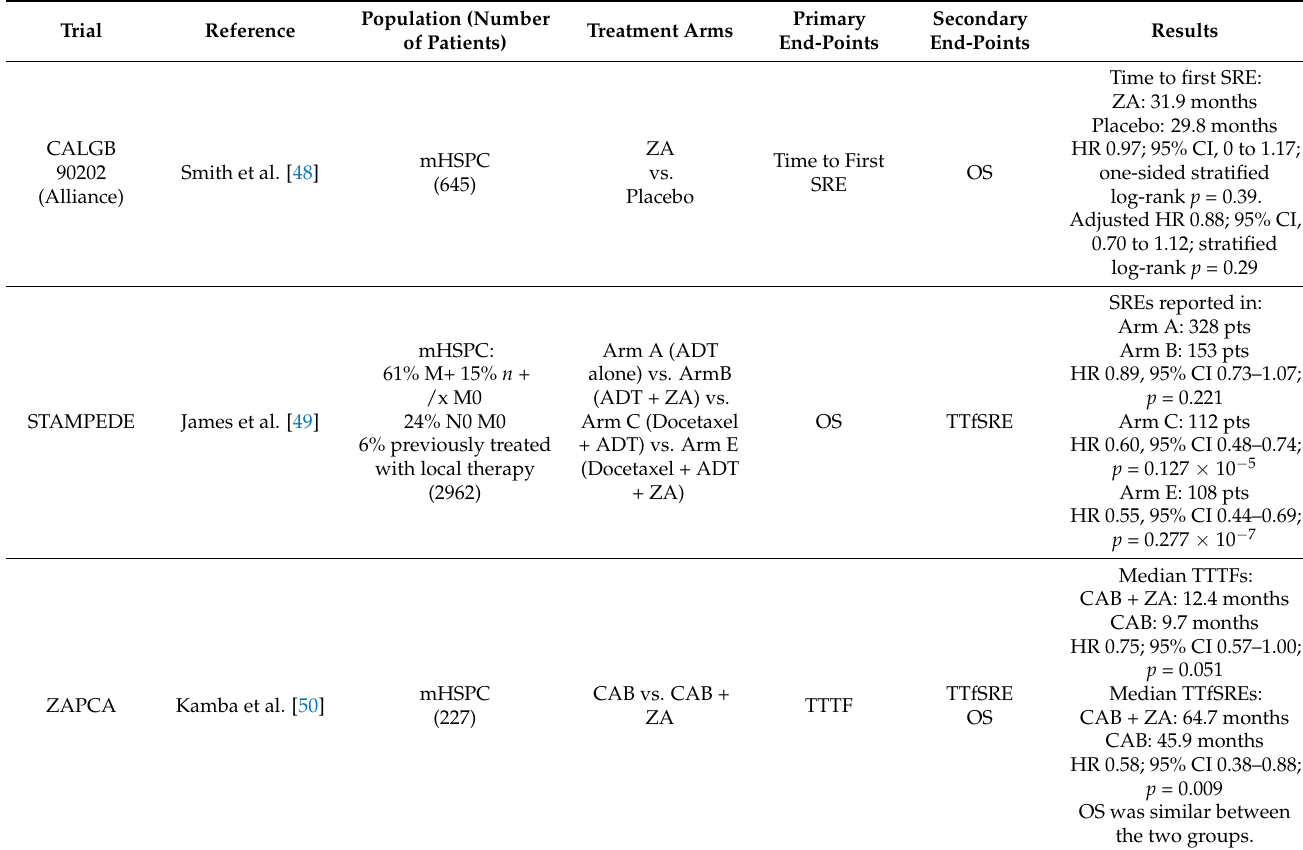
Table 1. Pivotal clinical trials investigating bone targeting agents in